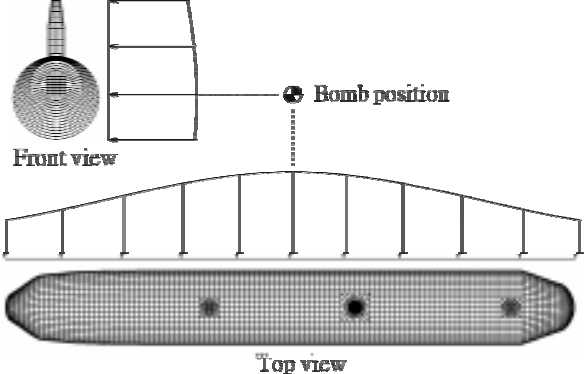
Fig. 7. Bomb position and pressure